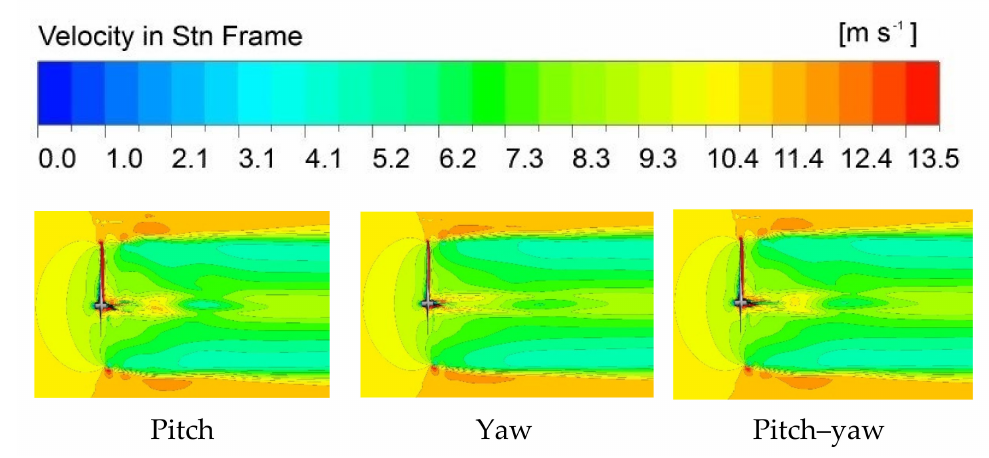
Figure 18. Velocity distribution at Position 3.